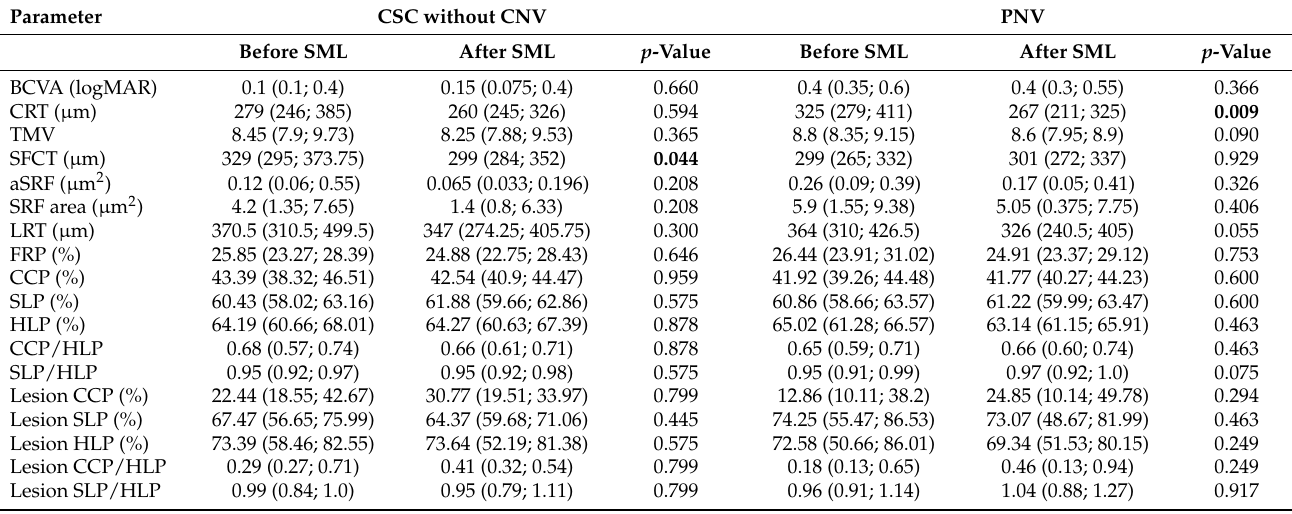
Table 5. Change in anatomical and functional parameters four weeks after SML in each subgroup.